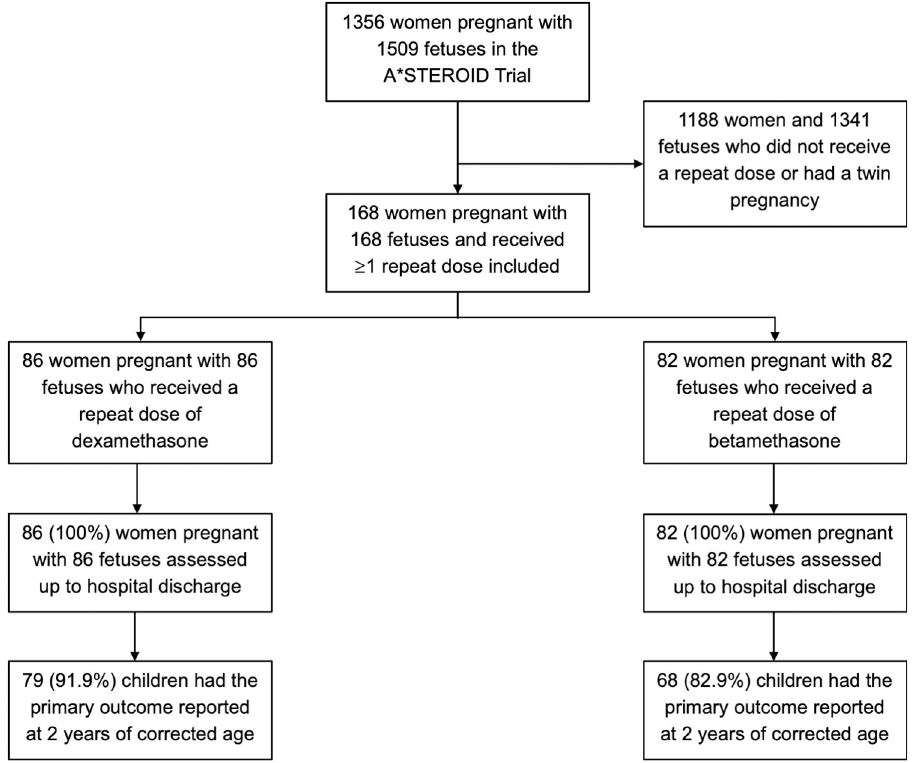
Fig 1. Women and infants included in study